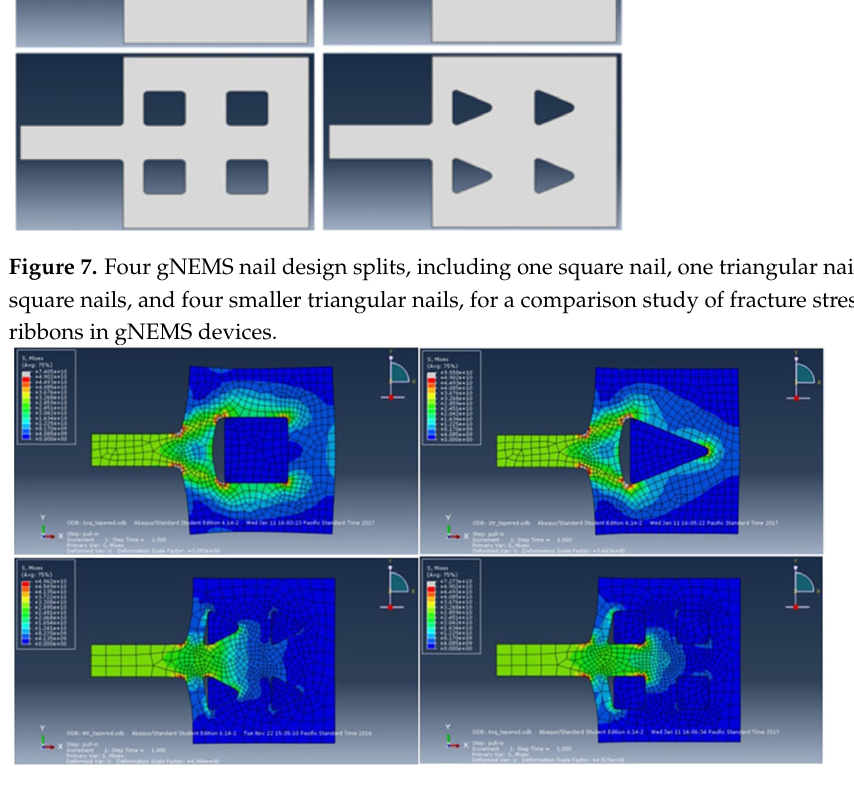
Figure 8. FEM simulations of fracture stress in graphene ribbons in gNEMS devices with four nail designs: single square nail, single triangular nail, four smaller square nails, and four triangular nails. Table 1. Summary of the simulated fracture stress for the four nailed gNEMS devices. Nail